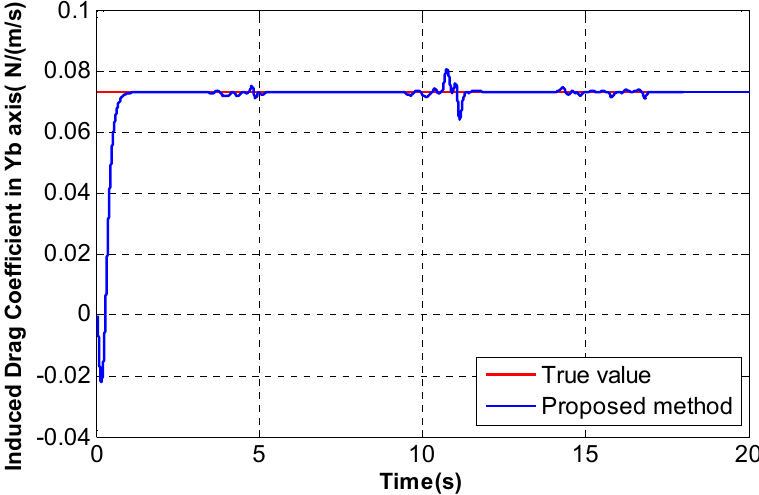
Figure 10. Induced drag coefficient estimation value in Yb axis.